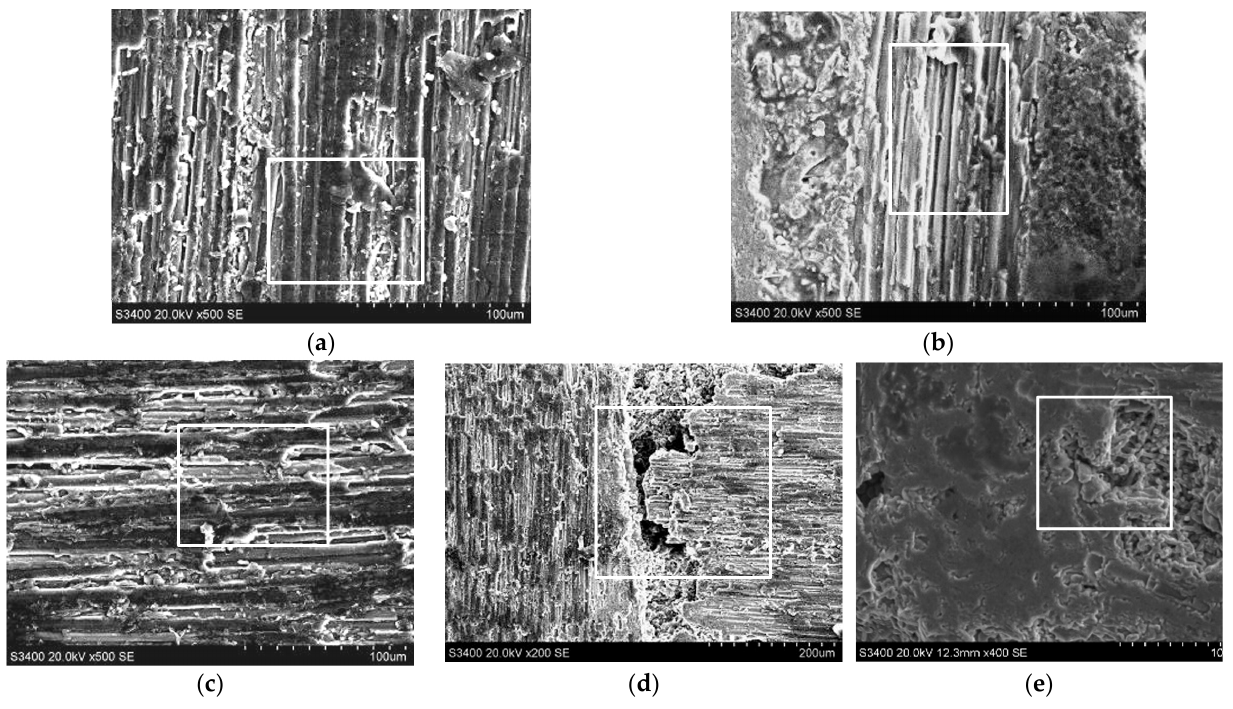
Figure 8. Surface damage types of the C/SiC composite after end face grinding. ( a ) 90° fiber laminar brittle fracture. ( b ) 0° fiber pullout. ( c ) 0° fiber step brittle fracture. ( d ) Pores. ( e ) Collapse fracture in SiC region.